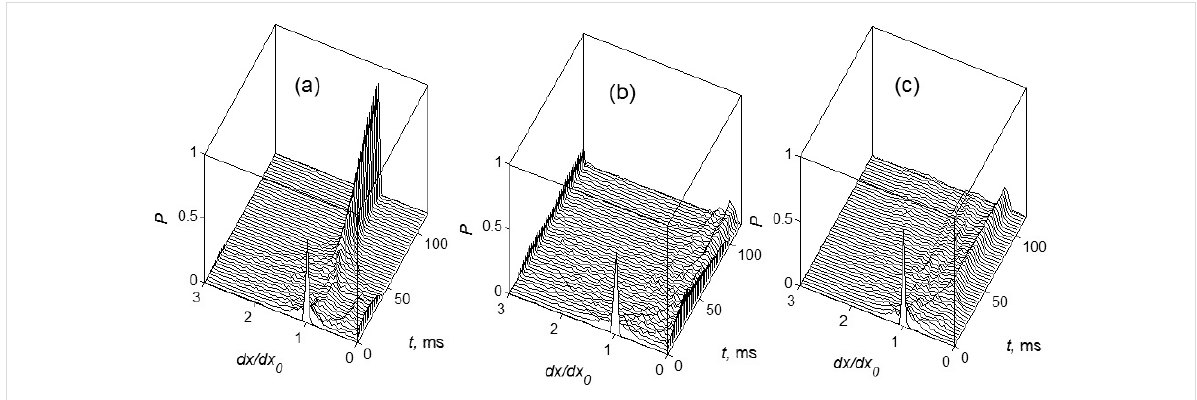
Figure 6: Statistical analysis of the plots presented in Figure 5. The sequences of the histograms show time evolution of the probability P = P ( dx ) to find a particular value of the distance dx j = x j +1 − x j between nearest fibers. The cases (a)–(c) are the same as above. Starting from unperturbed con- figuration (initial peak of probability around dx j = dx 0 ) all the systems evolve to the smooth distributions P ( dx ). In clustered attached state (see cases (a) and (b)) the probabilities have well pronounced maximums at dx ≈ 0. After detachment from the surface all the systems tend to the distributions P ( dx ), which perfectly agree with the observed final states shown in Figure 3 and Figure